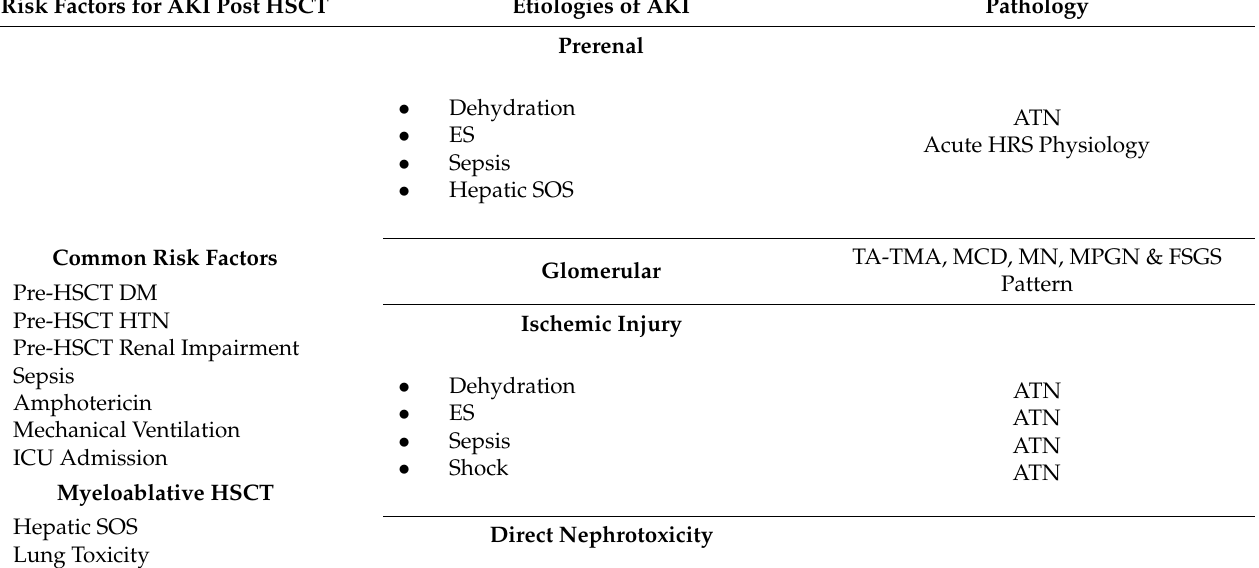
Table 3. Risk factors, etiology and pathological phenotype of AKI in HSCT [70,75,76]. Risk Factors for AKI Post